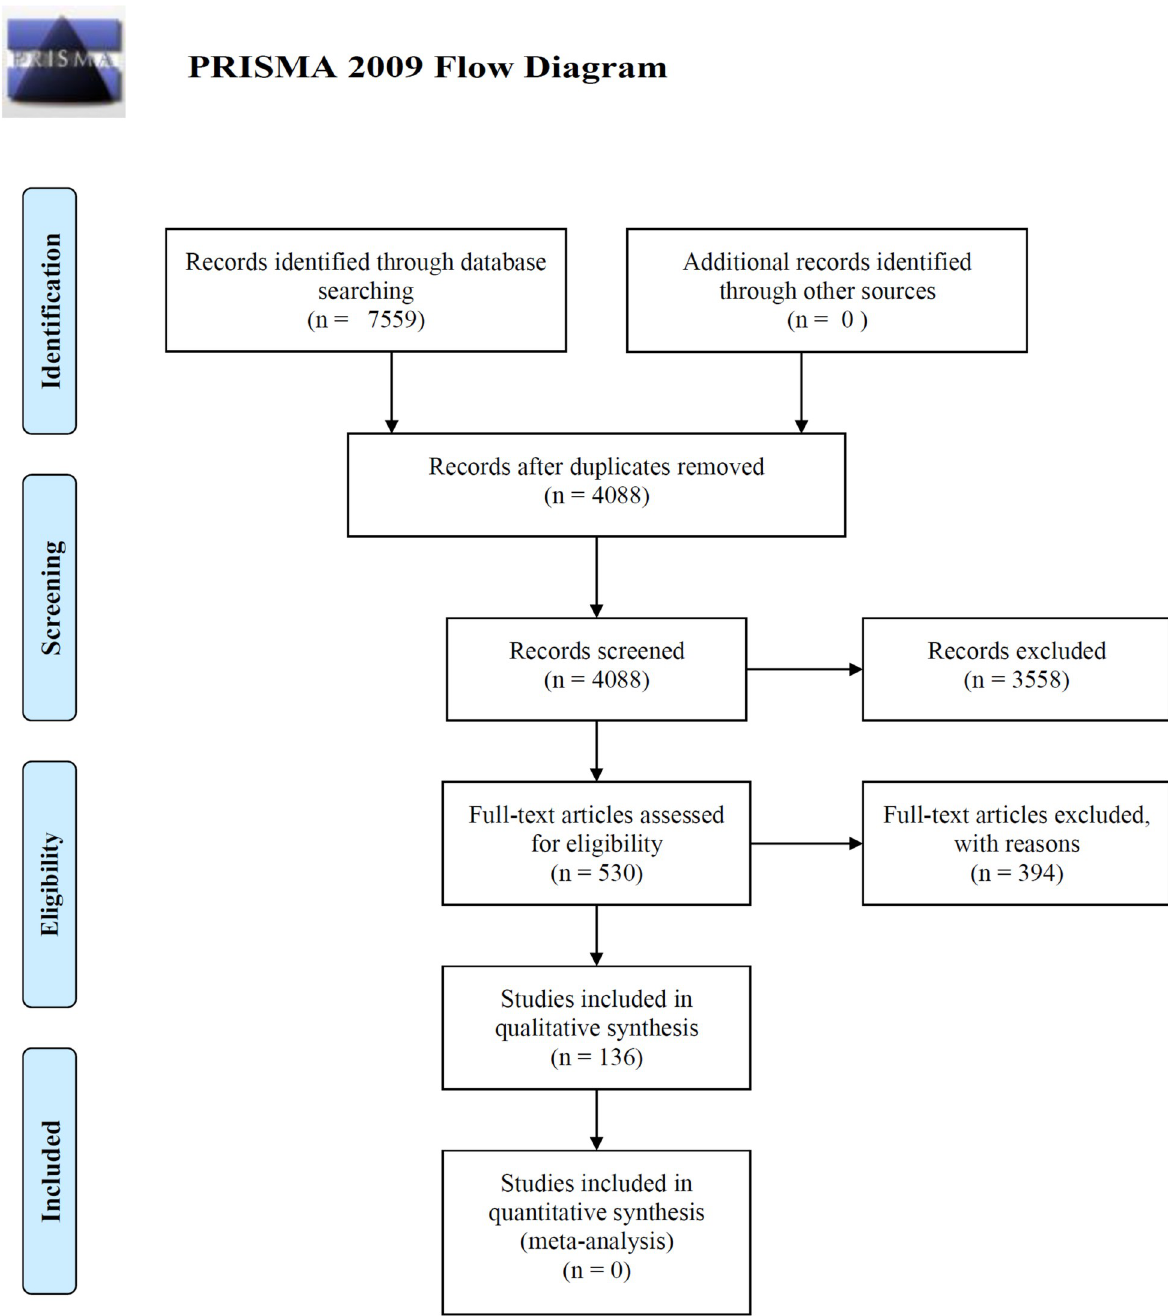
Fig 1. PRISMA 2009 flowchart describing the process of selecting articles for inclusion in the qualitative synthesis of our systematic review.